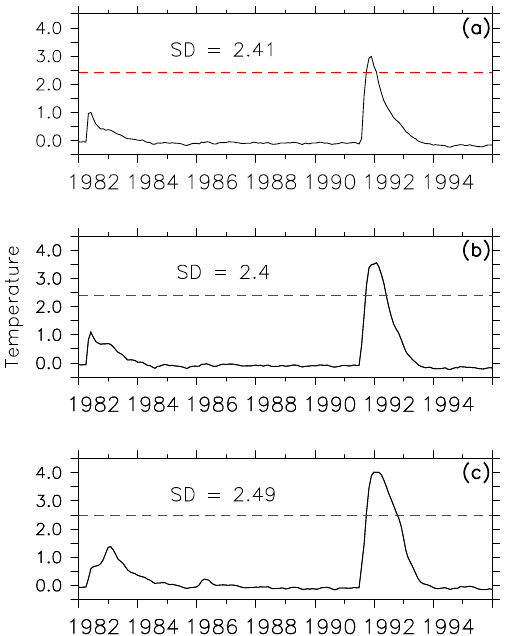
Figure 5. Temperature (K) differences (VOL-NOVOL) for the tropics (5 ◦ S–5 ◦ N), zonally averaged after the March 1982 El Chichón and the June 1991 Mount Pinatubo eruption for (a) 20hPa, (b) 30hPa, and (c) 50hPa. Red dashed lines indicate the standard deviation (K) for the unperturbed NOVOL simulation in the same region, calculated over the whole time series of